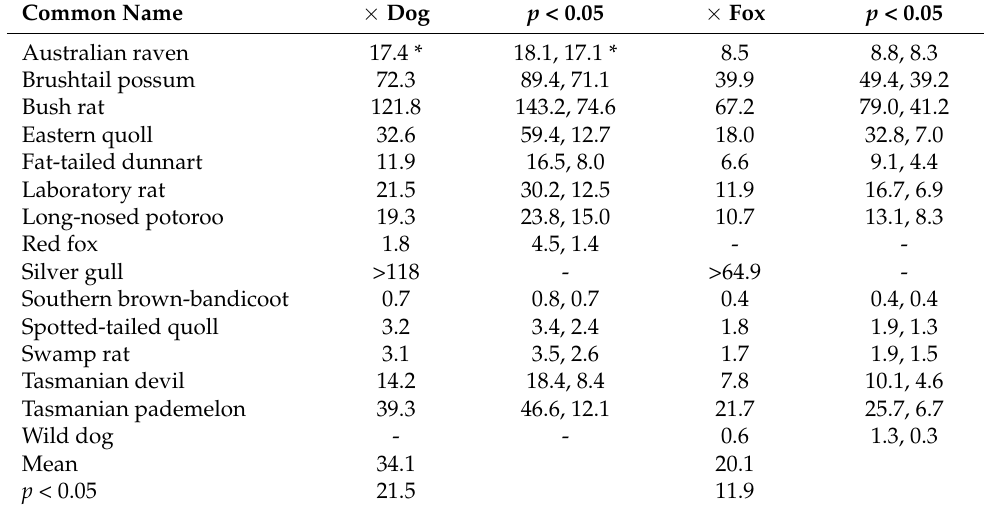
Table 2. Comparative species sensitivity referenced to the multiple of red fox and wild dog sensitivity based on the dose of PAPP mg kg − 1 required to cause 80% MetHb in each with upper and lower confidence estimates ( p <